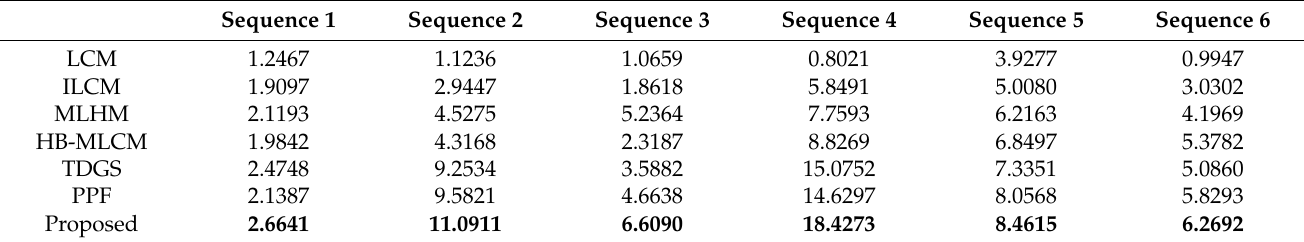
Table 2. The comparisons of BSF under different